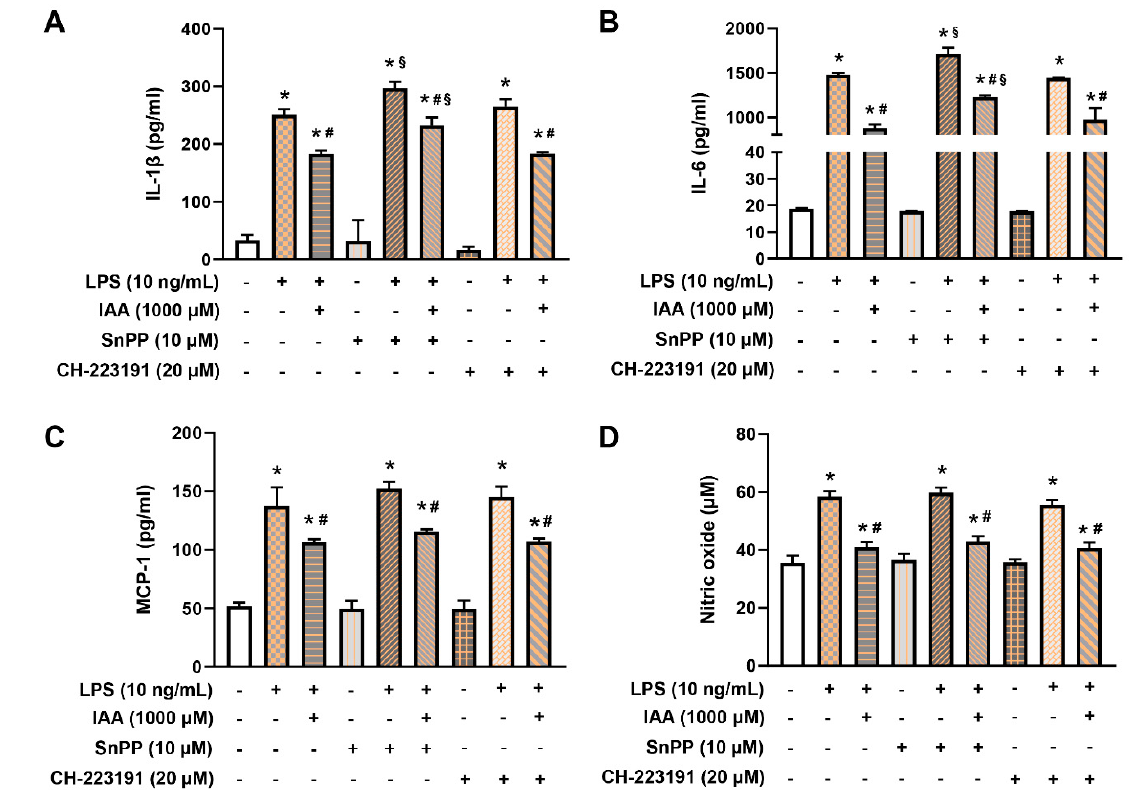
Figure 6. Effect of SnPP and CH-223191 on the protective action of IAA on generation of IL-1 β , IL-6, MCP-1, and NO induced by LPS in RAW264.7 cells. The supernatants of cultured RAW264.7 were subjected to analysis of ( A ) IL-1 β , ( B ) IL-6, ( C ) MCP-1, and ( D ) NO content after pretreatment with IAA (1000 µ M) plus SnPP (10 µ M) or CH-223191 (20 µ M) for 12 h followed by LPS (10 ng / mL) exposure for 16 h in the presence or absence of IAA and SnPP / CH-223191. Results are given as mean ± SEM. n = 3. * p < 0.05 versus control group. # p < 0.05 versus LPS, LPS + SnPP, or LPS + CH-223191 group. § p < 0.05 versus corresponding control group treated with LPS or LPS + IAA without SnPP and CH-223191. SnPP, tin protoporphyrin IX; NO, nitric oxide; IAA, indole-3-acetic acid; LPS, lipopolysaccharide.